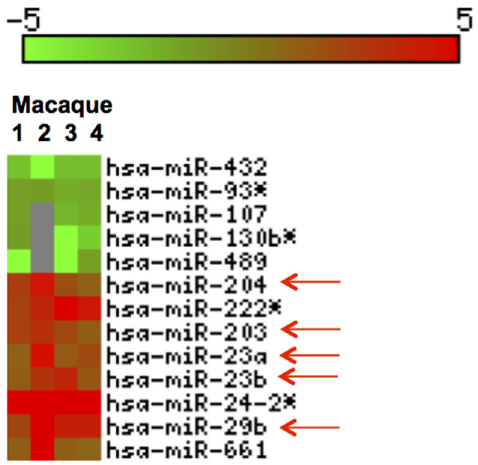
Figure 6. Heat Map of differentially expressed (DE) miRNAs in GS macaques. Values corresponding to jejunum of four GS macaques normalized against average of 5 normal healthy controls are shown. Eight out of 13 DE miRNAs were significantly upregulated ( red ) and the remaining five were downregulated ( green ) ( p < 0.05). Red arrows indicate miRNAs previously reported and linked to inflammatory disorders [55–61].